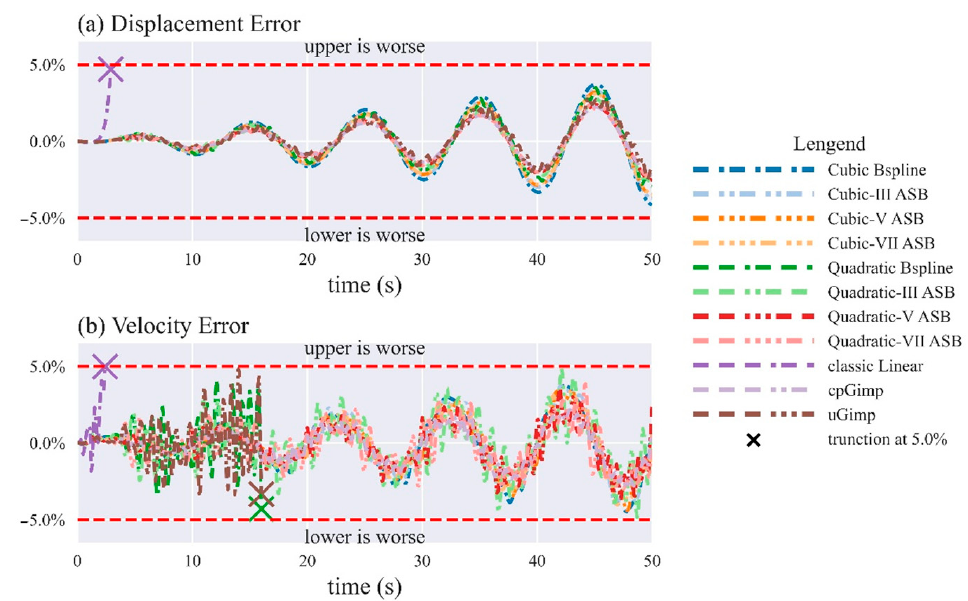
Figure 7. D continuum bar vibration results (the free-end particle) for variations of the MPM algorithm under the initial velocity amplitude v 0 = 0.75 m/s: ( a ) the relative error of displacement against the analytic solution, and ( b ) the relative velocity error against the analytic solution. For clarity, some series are truncated when their relative errors increase beyond 5.0%.